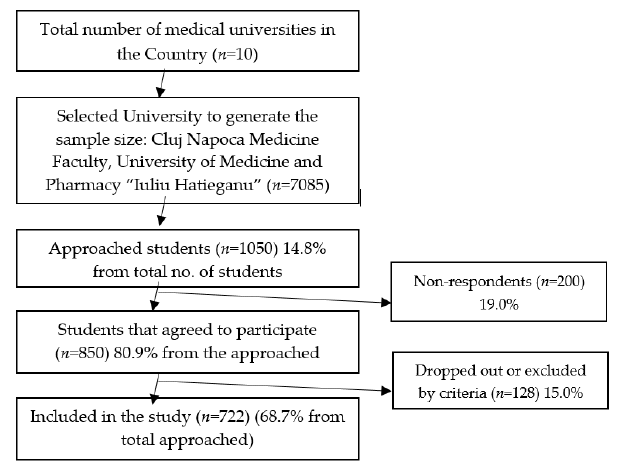
Figure 1. Reporting flow diagram.